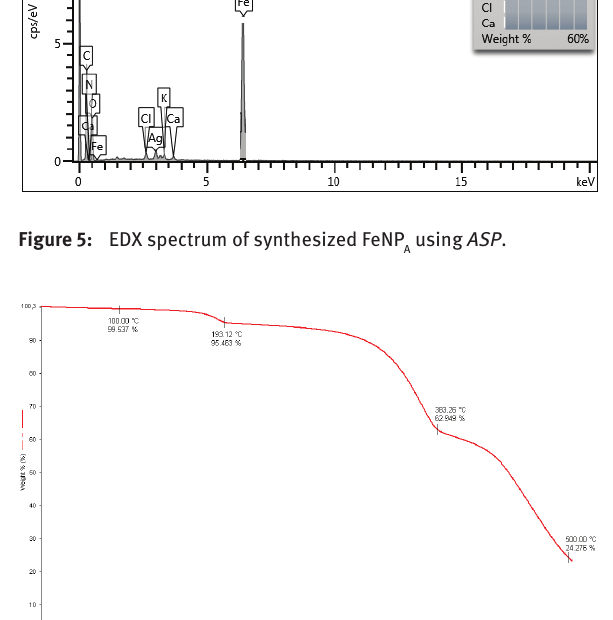
Figure 3: Transmission electron microscopy (TEM) images of FeNP synthesized by ASP .